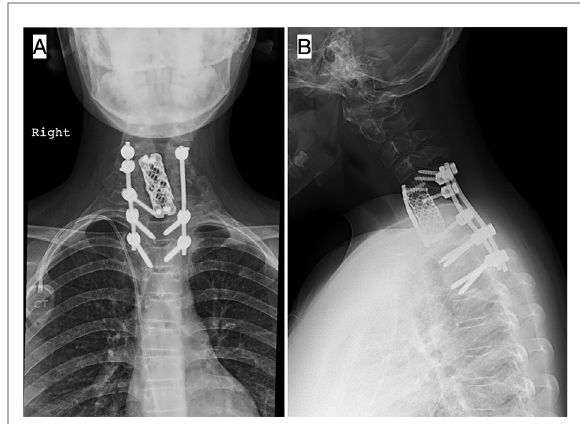
FIGURE 6 Anteroposterior ( A ) and lateral ( B ) x-rays of the cervical spine at 3 years postoperatively: interbody moss mesh, anterior plate fi xation, and bilateral posterior instrumentation fusion with screws and rods from C5 to T3. Adequate alignment and balance, without signs of implant loosening or lack of